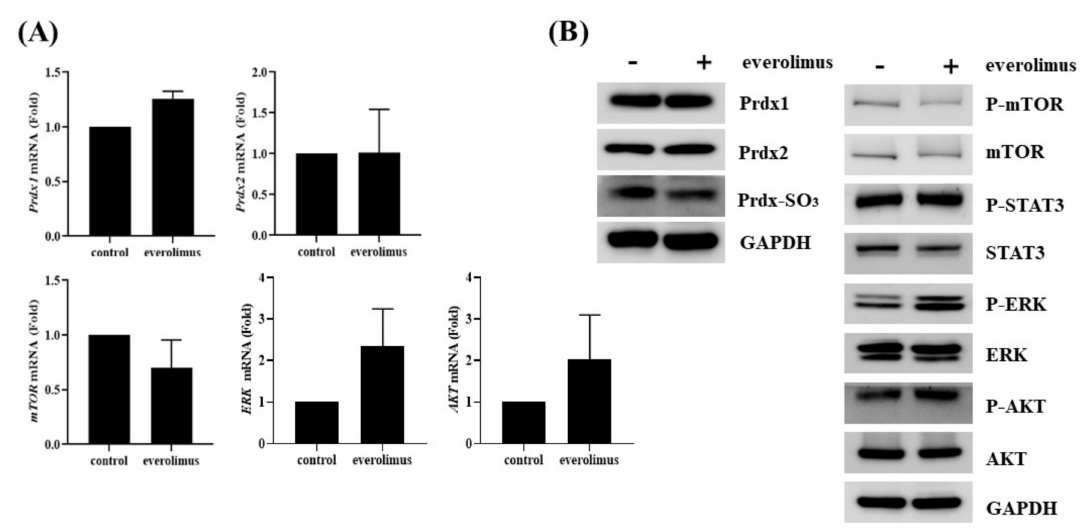
Figure 2. E ff ects everolimus on QGP-1 cells. ( A ) Everolimus downregulated mTOR expression and upregulated that of ERK and AKT in QGP-1 cells; ( B ) Western blotting showed that the levels of mTOR and phosphorylated mTOR decreased, whereas those of Prdx1, Prdx2, and Prdx-SO3 were unchanged in QGP-1